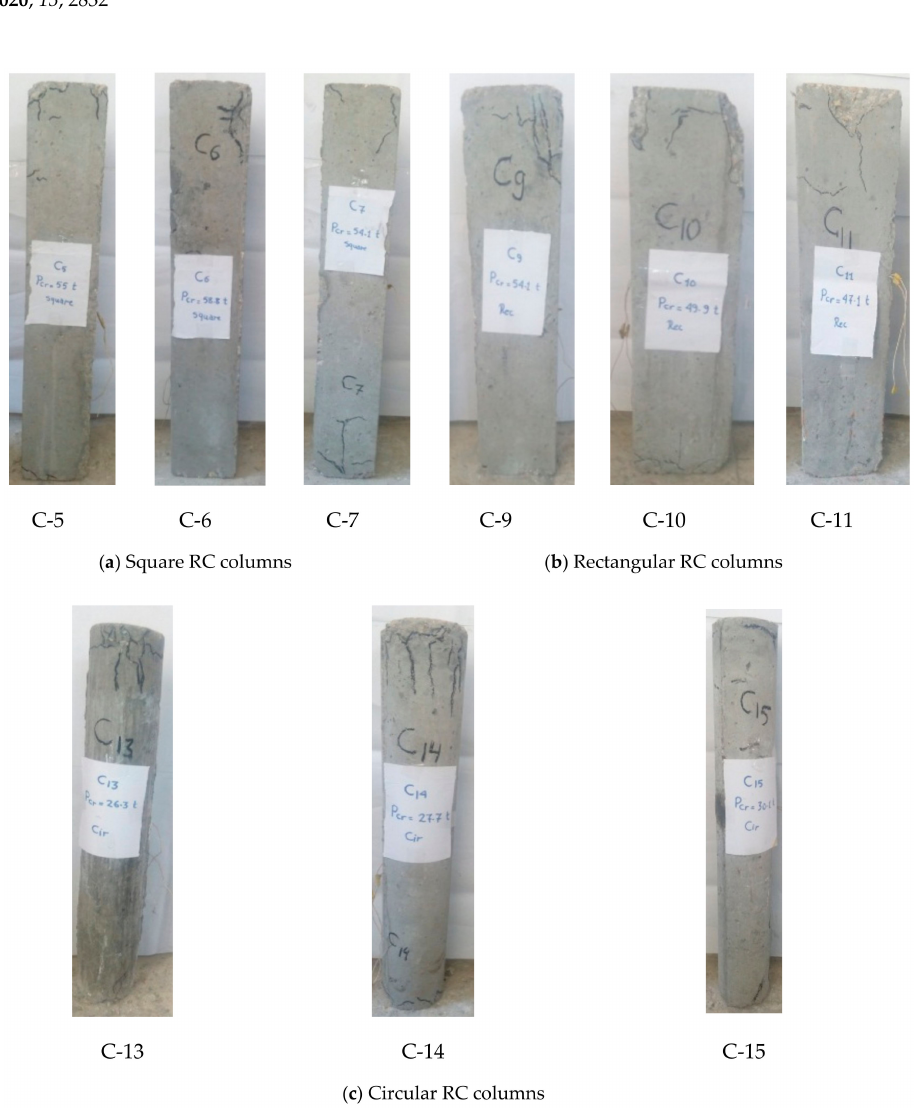
Figure 5. Crack patterns of the RC columns without strengthening.